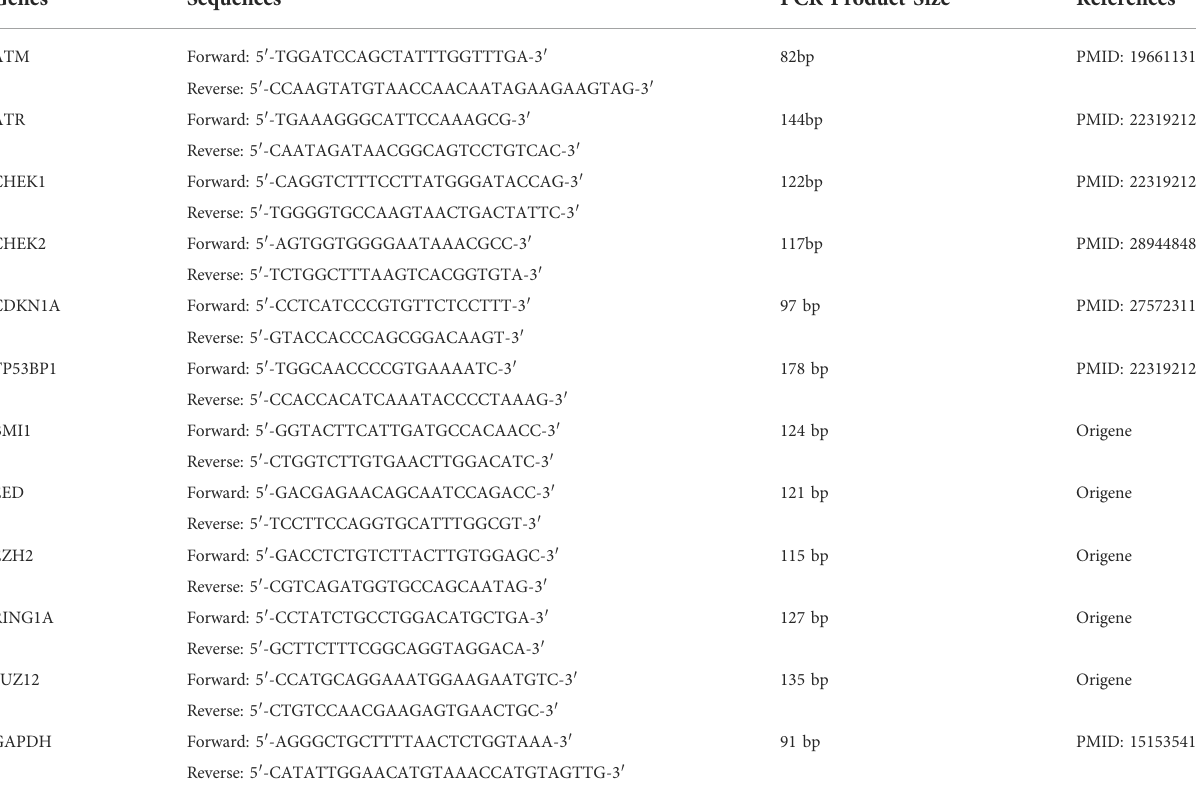
TABLE 1 Real-time PCR primer